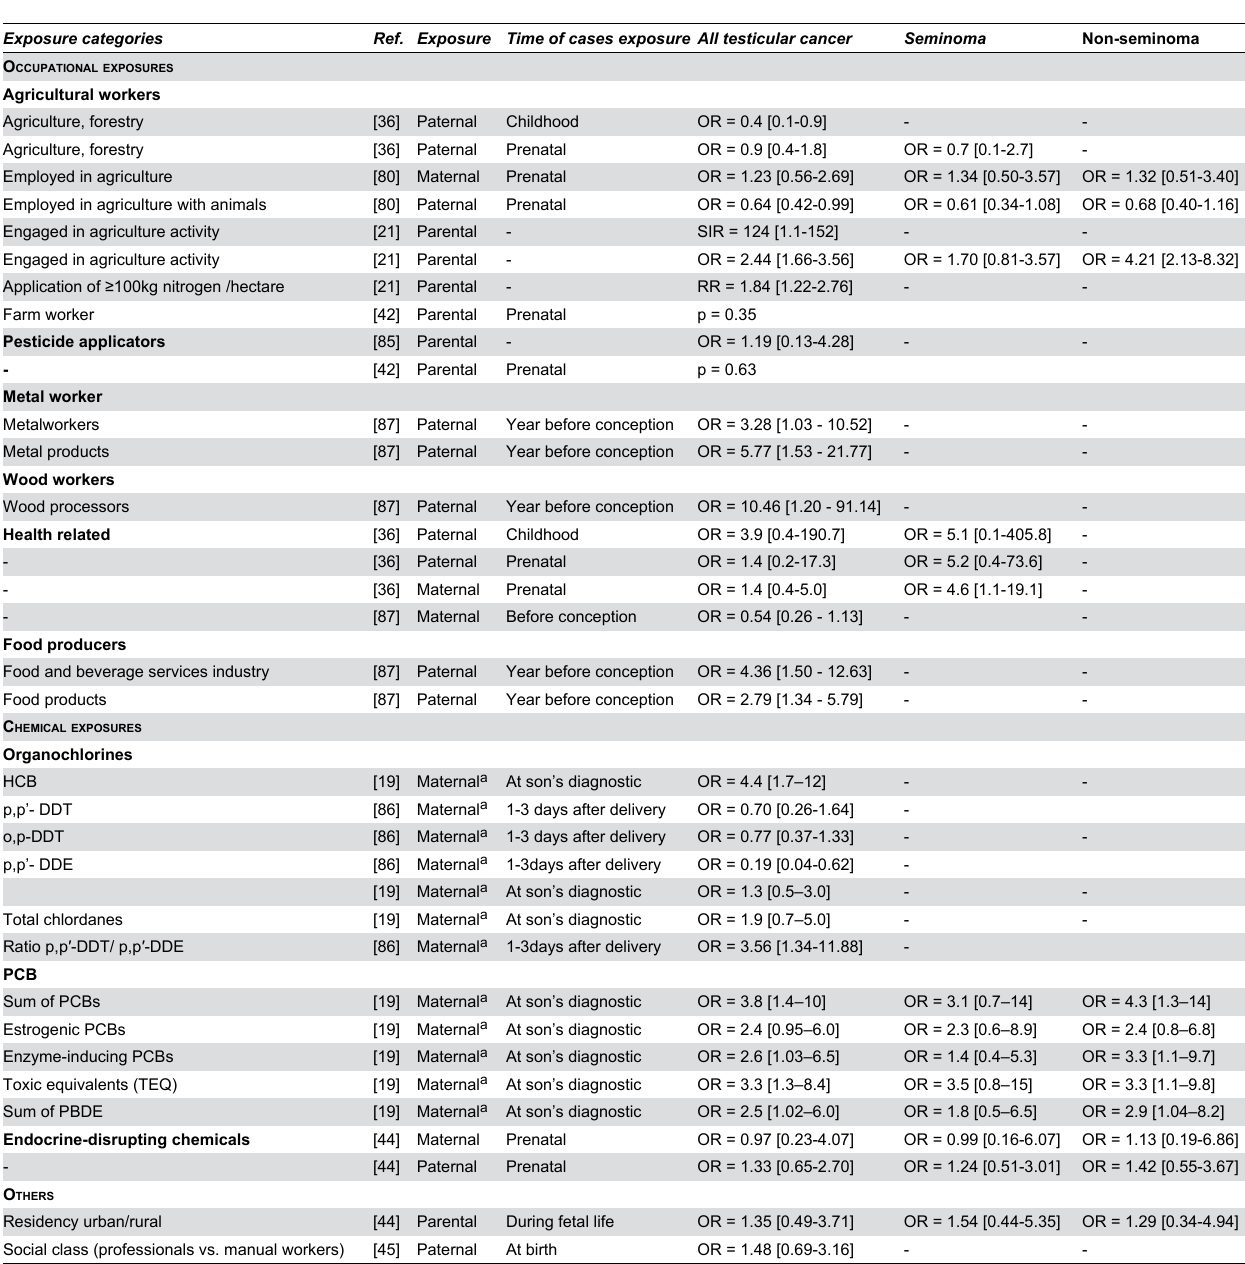
Abbreviations: HCB = Hexachlorobenzene, DDT = dichlorodiphenyltrichloroethane; DDE = Dichlorodiphenyldichloroethylene; PCB = polychlorinated biphenyl; PBDE